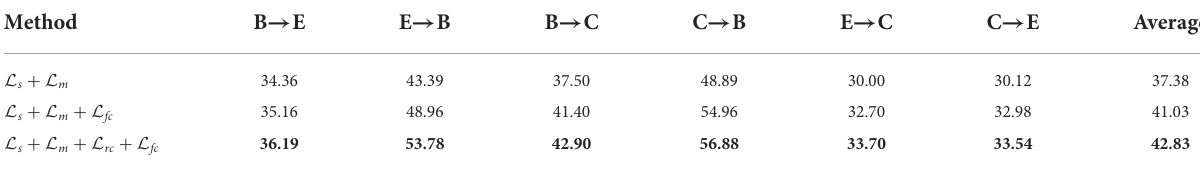
TABLE 3 Experimental results of PDAN with different total loss functions for six cross-corpus SER tasks, in which the best results are highlighted in bold.